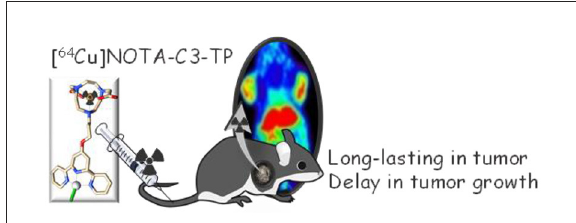
GRAPHICAL ABSTRACT Long tumor retention time and tumor growth inhibition from a novel chemo-radio-theranostic agent.